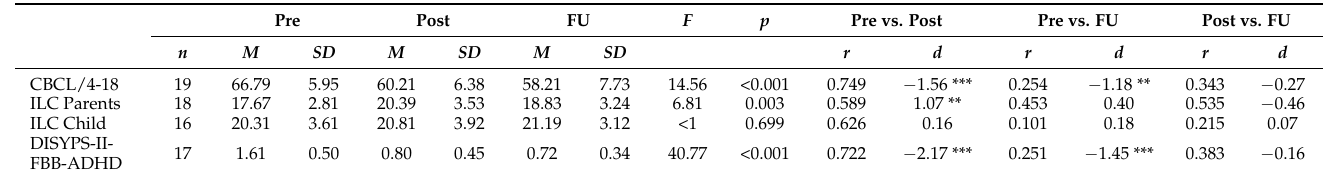
Table 5. Means, standard deviations, repeated-measures analyses of variance, and post hoc compar- isons with effect sizes for secondary outcome